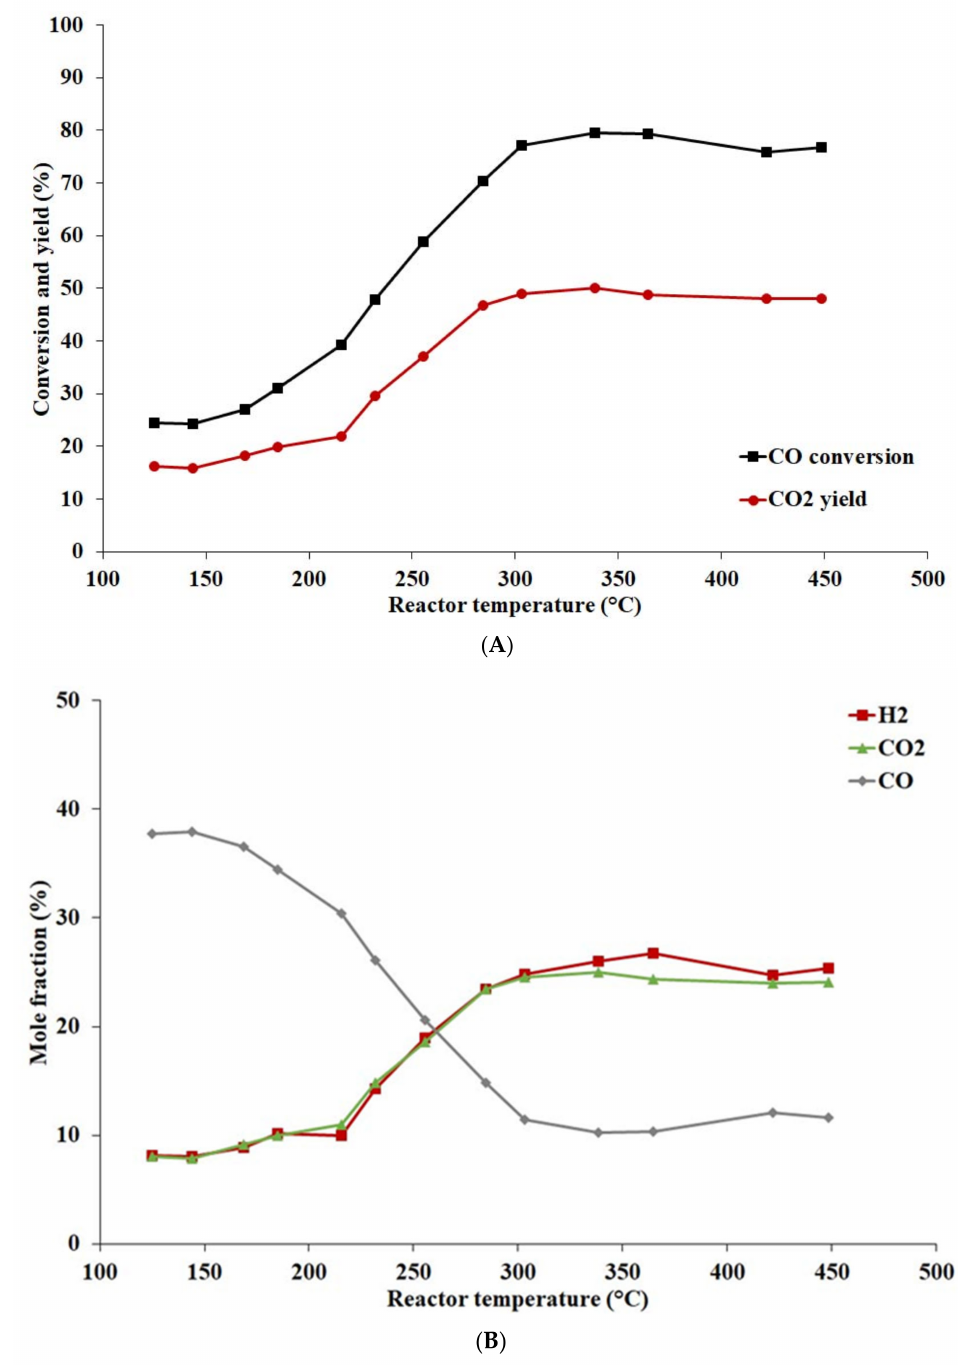
Figure 12. Catalytic tests on a Cu-based (14.8 wt%) activated catalyst, prepared with calcined support, with feed gas mixture 1 (50 mole% CO, 50 mole% N 2 ) at pressure 0.5 MPa; flow rate 6 L min − 1 : ( A )—CO conversion and CO 2 yield; ( B )—composition of produced